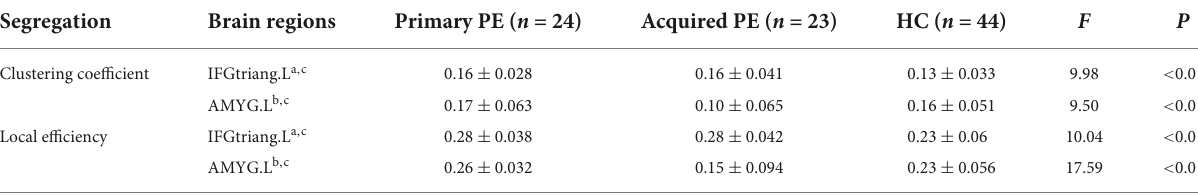
TABLE 3 Brain regions with abnormal segregative parameters between primary PE, acquired PE and HC